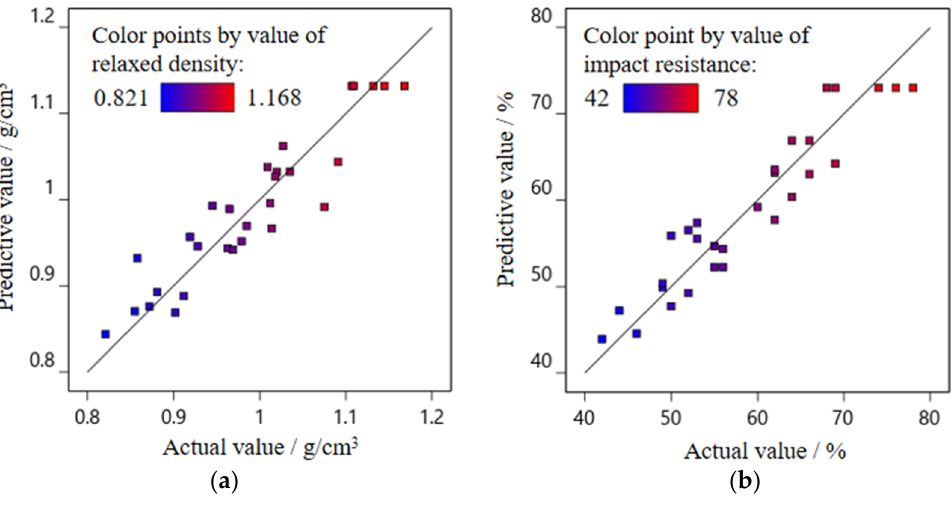
Figure 6. Relationship between experimental and predicted value: ( a ) relaxed density; ( b ) impact resistance.